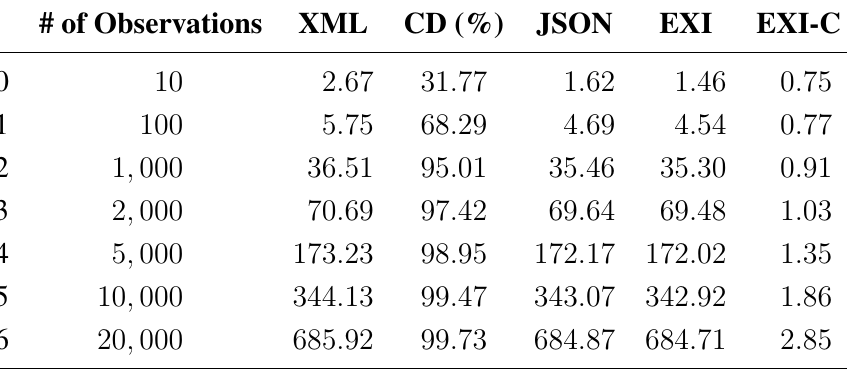
Table 4. Size of files (KBs) for each format and content density (CD) of the original XML files (IO